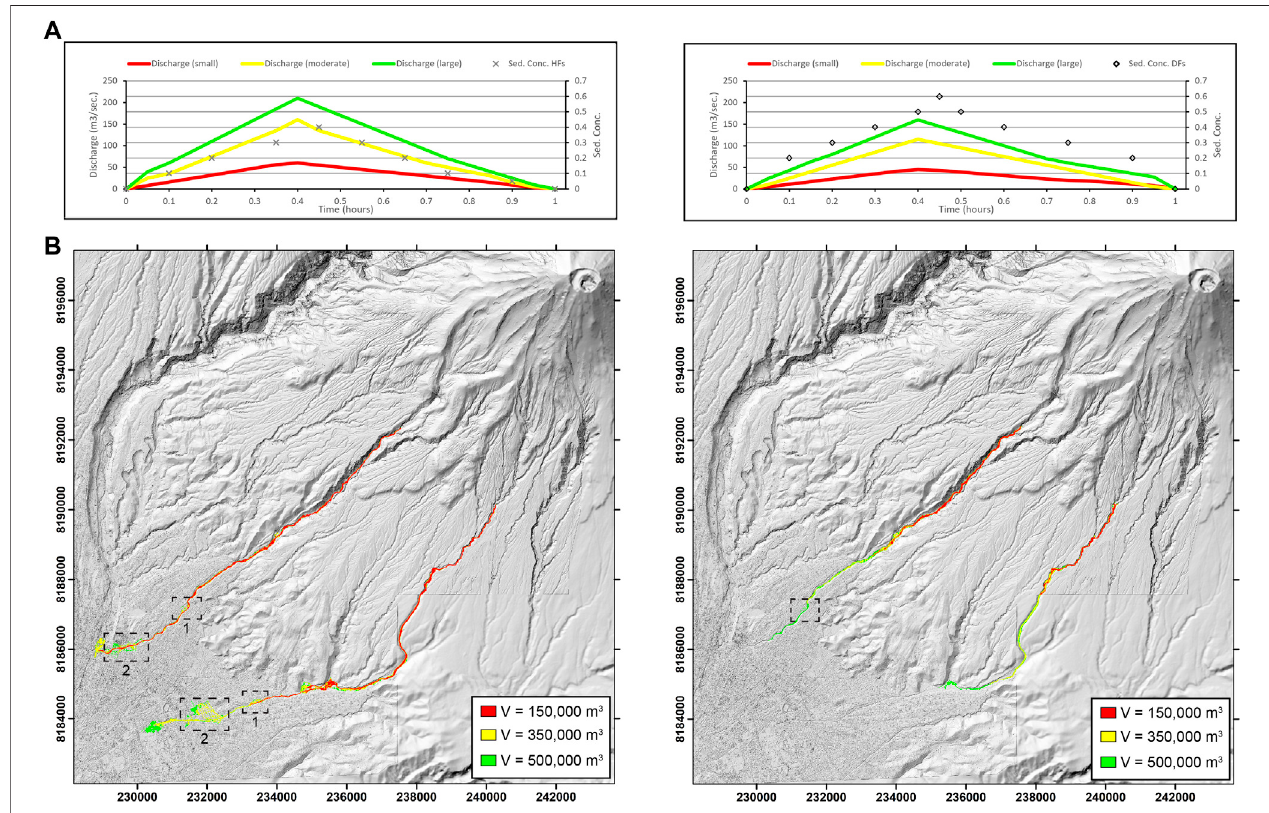
FIGURE 6 | FLO-2D simulation results for three HCFs (to the left-hand side) and three DFs (to the right-hand side) events in the San Lazaro and Huarangal catchments. (A) In fl ow hydrographs for the three HCF and DF events considered: small-volume (red), moderate-volume (yellow), and large-volume (green). Sediment volumetric concentrations are also shown. (B) . Inundation map of the three simulated HCFs (left) and DFs (right). Dashed black rectangles and numbers show the major overbank areas along both catchments (see text for explanation).